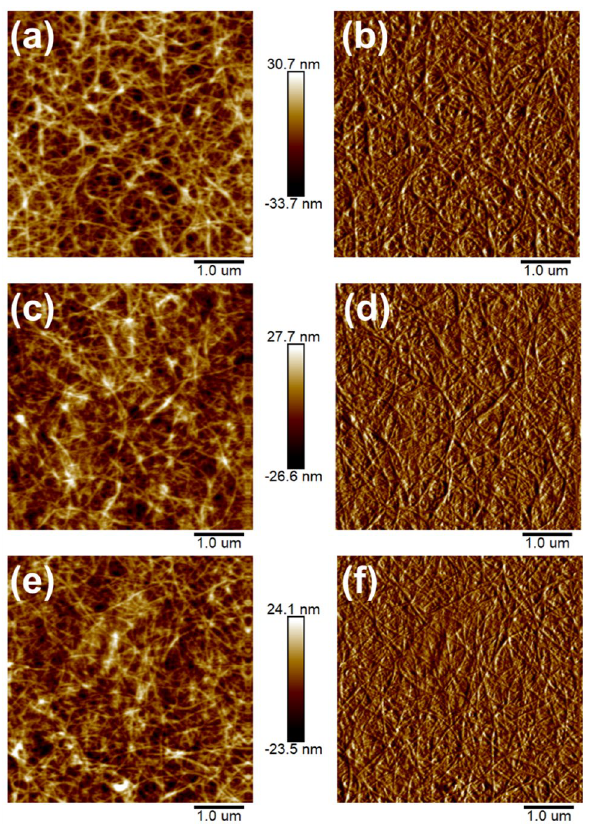
Figure 7. AFM height and peak force error diagrams: ( a , b ) Pure CNT films; ( c , d ) S-RGO/CNT0.5 films; ( e , f ) S-RGO/CNT1.0